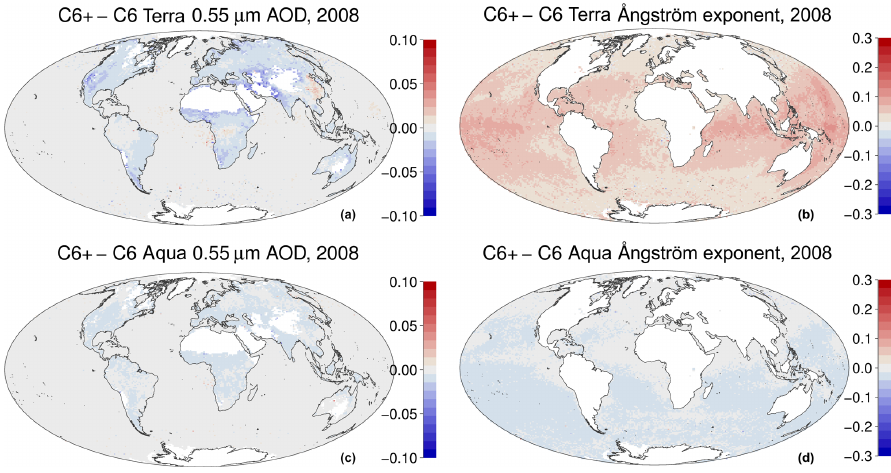
Figure 11. Impact of applying C6 + calibration corrections to the MxD04 AOD (a, c) and AE (b, d) products. Panels (a, b) show impact on MOD04 (Terra), whereas panels (c, d) show impact on MYD04 (Aqua).